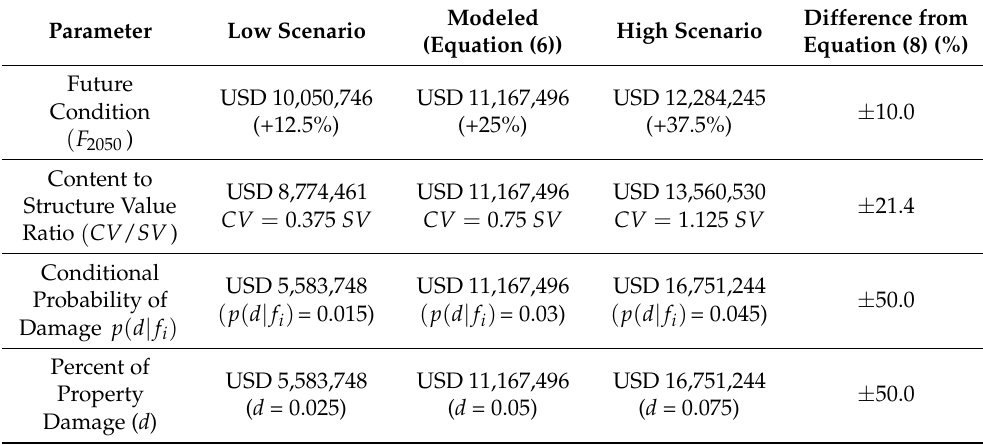
Table 1. Sensitivity analysis of 2050 projections of Louisiana statewide annual property loss (i.e., risk) due to wildfire, by parameter (in 2010 USD).